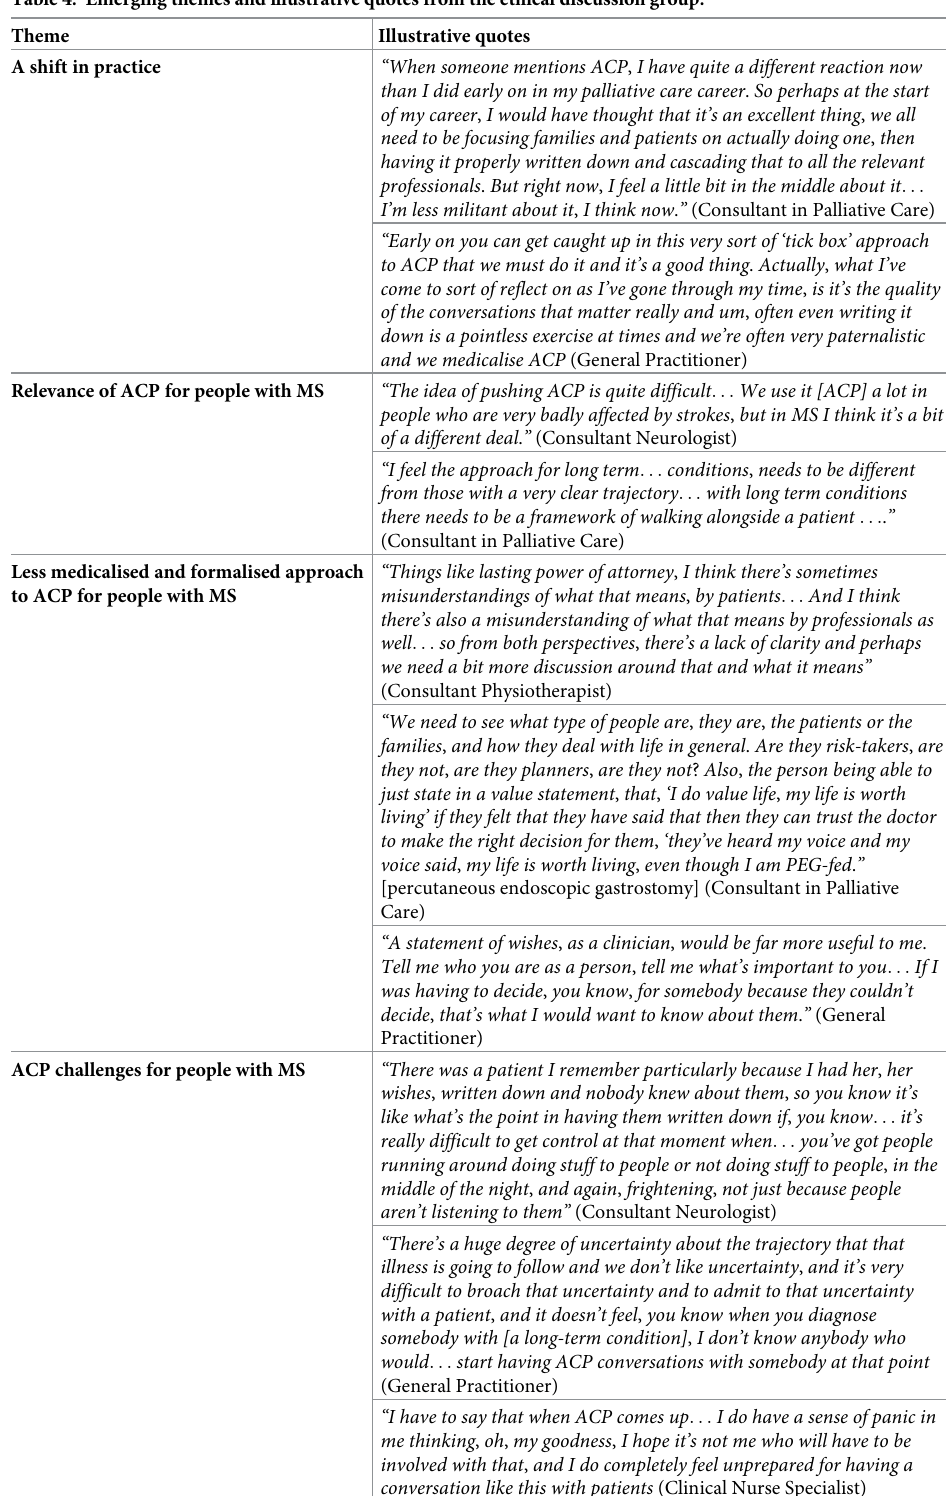
Table 4. Emerging themes and illustrative quotes from the ethical discussion